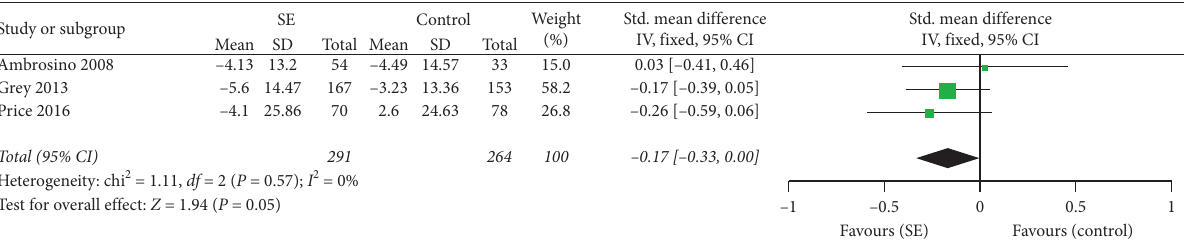
Figure 4: Effect size on changes in diabetes self-efficacy between the intervention and control groups in adolescent patients with